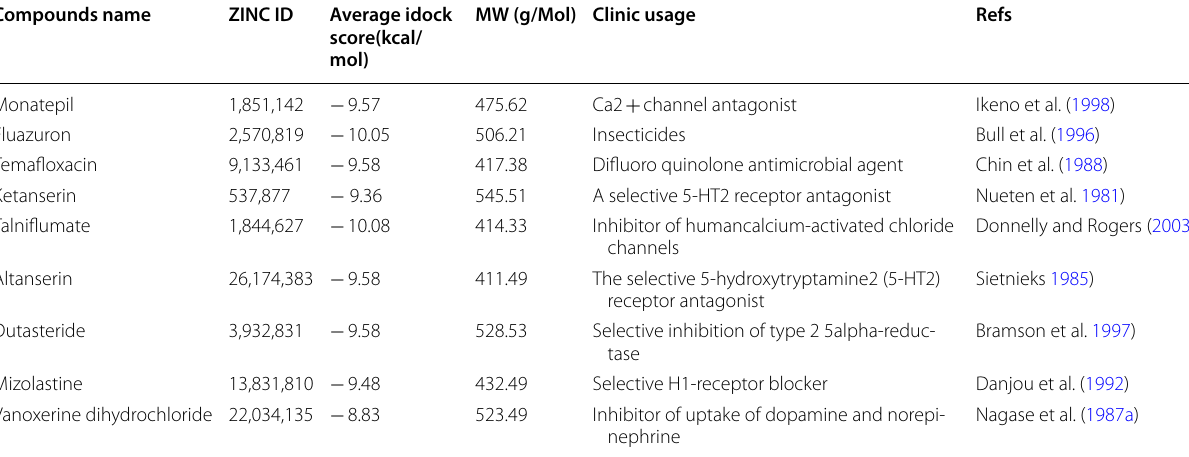
An idock score is the estimated binding free energy (kcal/mol units). Negative value implies a high predicted binding